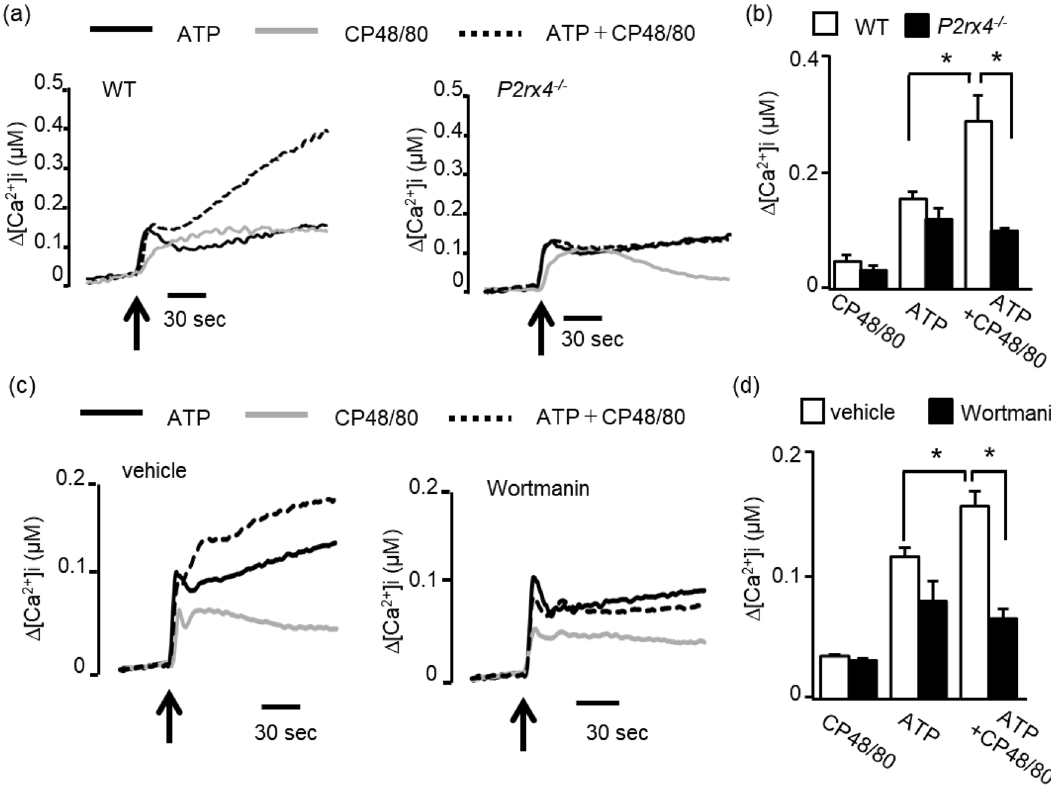
Figure 4. Effect of co-stimulation with ATP and CP48/80 on intracellular Ca 2+ concentration ([Ca 2+ ]i) levels in PMCs. ( a ) PMCs prepared from WT (left) or P2rx4 −/− (right) mice were loaded with Fura-2 AM, and changes in [Ca 2+ ]i were monitored after stimulation with ATP (black line, 100 μM), CP48/80 (gray line, 1 μM), or ATP plus CP48/80 (dotted line) at the time indicated by the arrow. The Ca 2+ data are representative of 4–5 independent experiments. ( b ) Summary of the data obtained in a . Results are shown based on [Ca 2+ ]i at 120 s after stimulation (WT, n = 4; P2rx4 −/− , n = 5). ( c ) WT PMCs were loaded with Fura-2 AM and preincubated for 2 min with vehicle or wortmannin (0.1 μM). Changes in [Ca 2+ ]i were monitored after stimulation with ATP (black line, 100 μM), CP48/80 (gray line, 1 μM), or ATP plus CP48/80 (dotted line) at the time indicated by the arrow. The Ca 2+ data are representative of 4–5 independent experiments. ( d ) Summary of the data obtained in c . Results are shown based on [Ca 2+ ]i at 120 s after stimulation (n = 4). Data are shown as the mean ± SEM. * p <